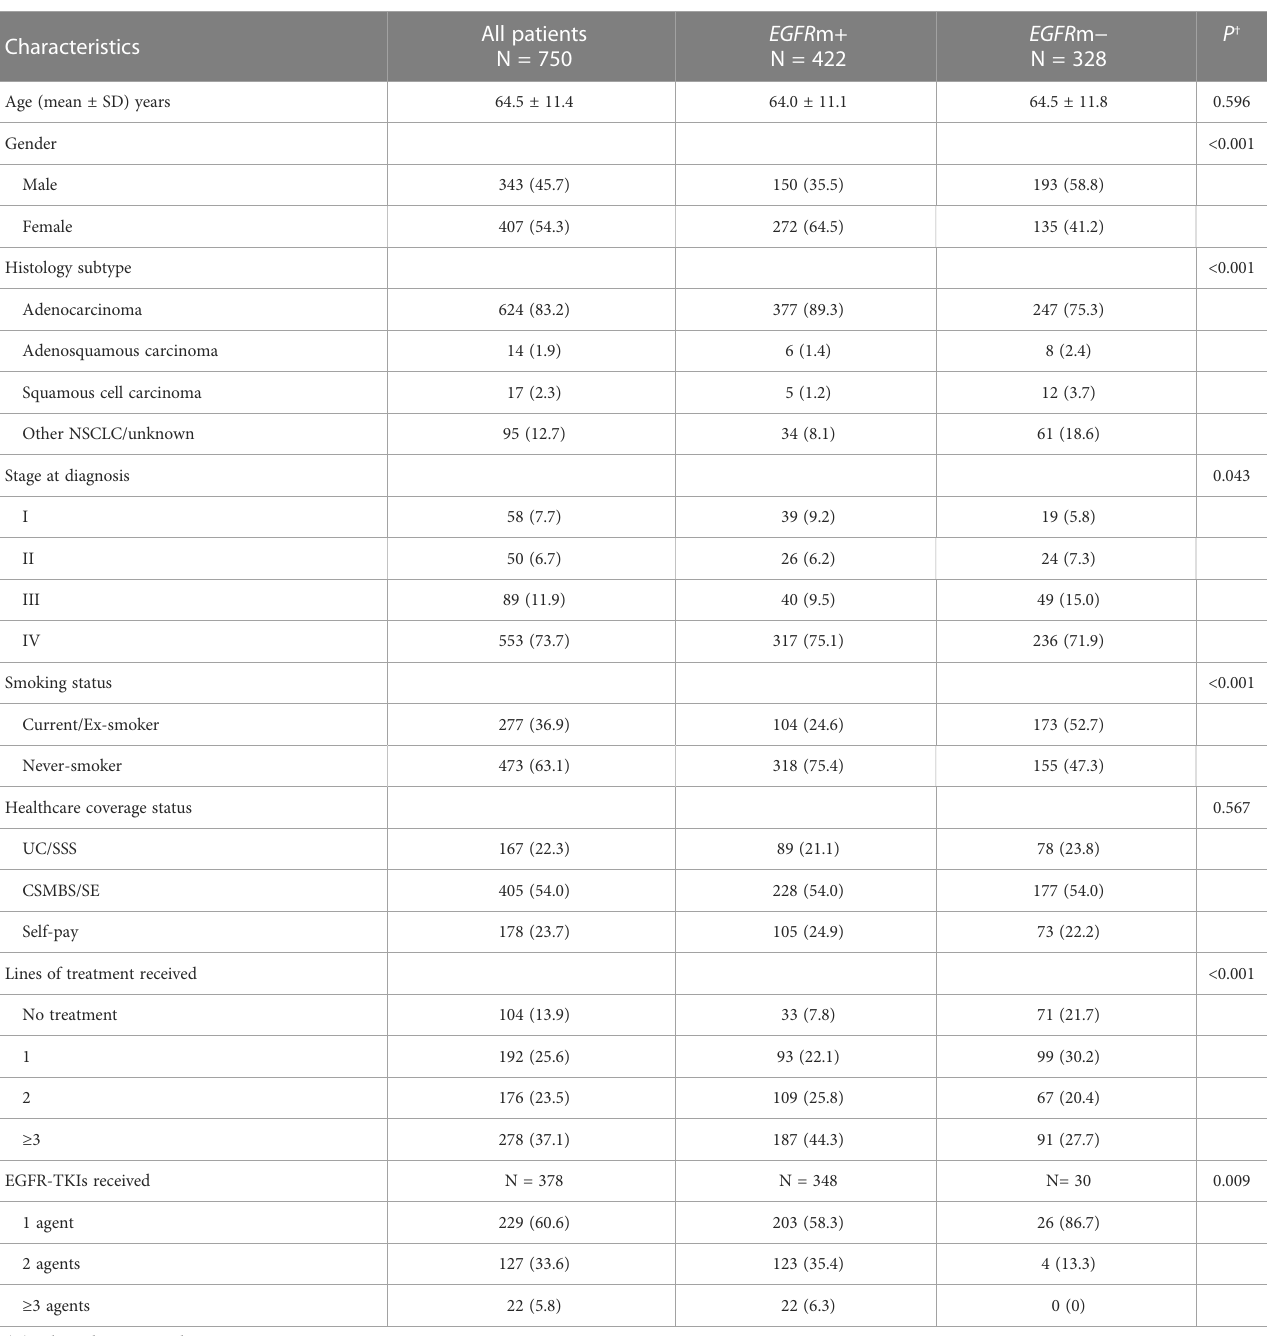
TABLE 1 Demographic